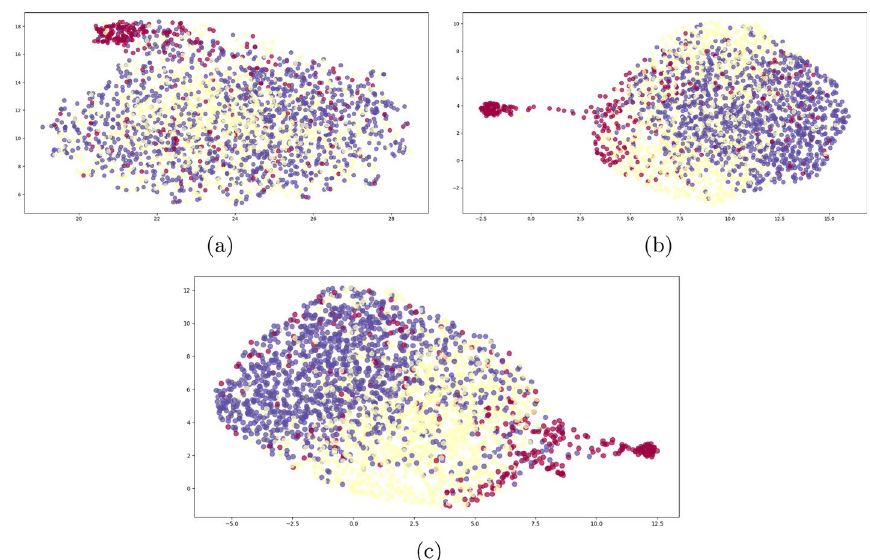
Fig. 13 UMAP 2D visualization of the entity embeddings on the IMDb-MLH dataset, with red, yellow and purple points indicating movies of genre ‘action’, ‘comedy’ and ‘drama’, respectively: the initial feature embedding with tf-idf weighting ( a ), the final entity embedding learned by Co-MLHAN-SA ( b ), and the final entity embedding learned by Co-MLHAN ( c